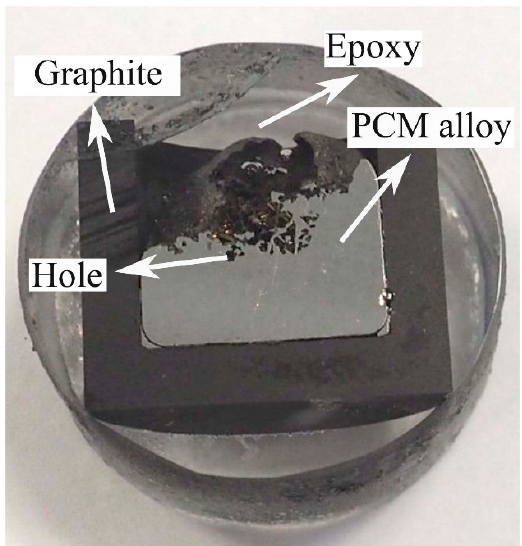
Figure 18. Photo of cross-sectioned graphite crucible with solidified Fe-26.38Si-9.35B alloy.